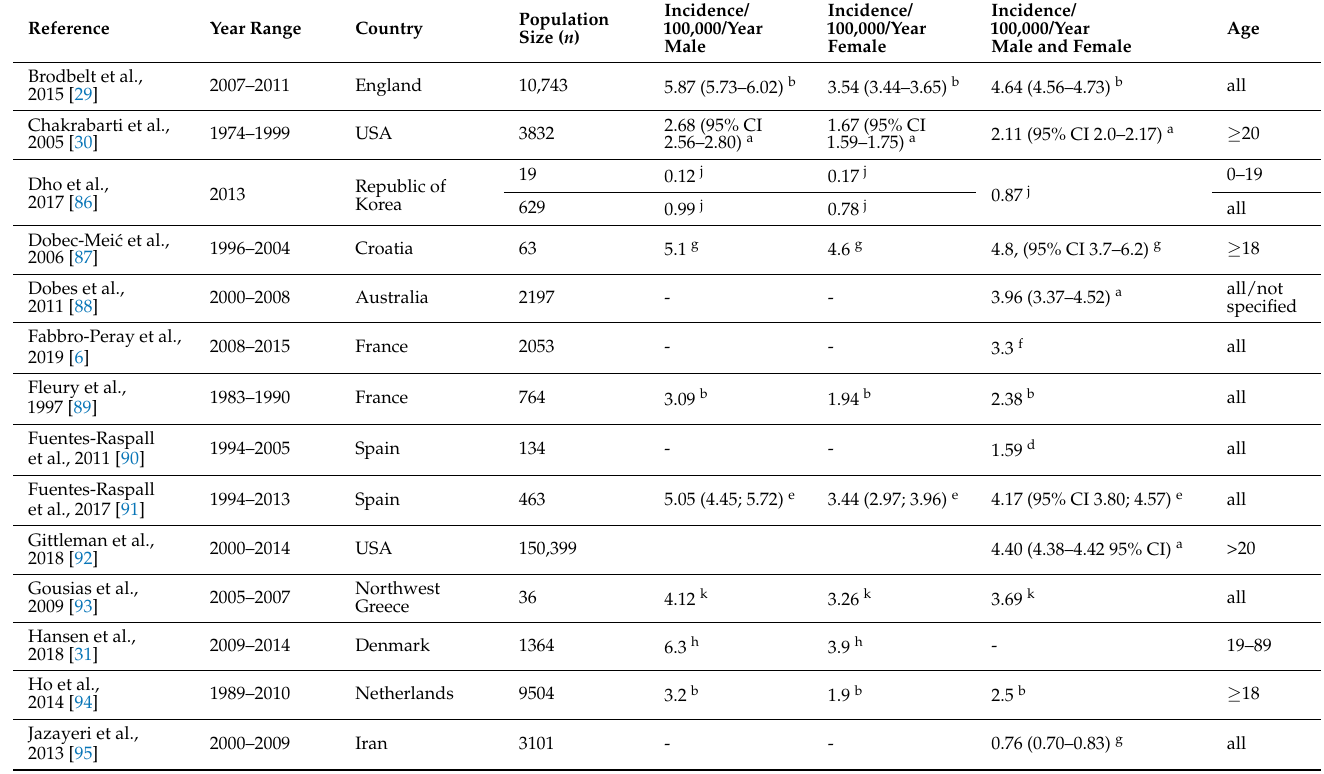
Table 1. Incidence rates of GBM for both